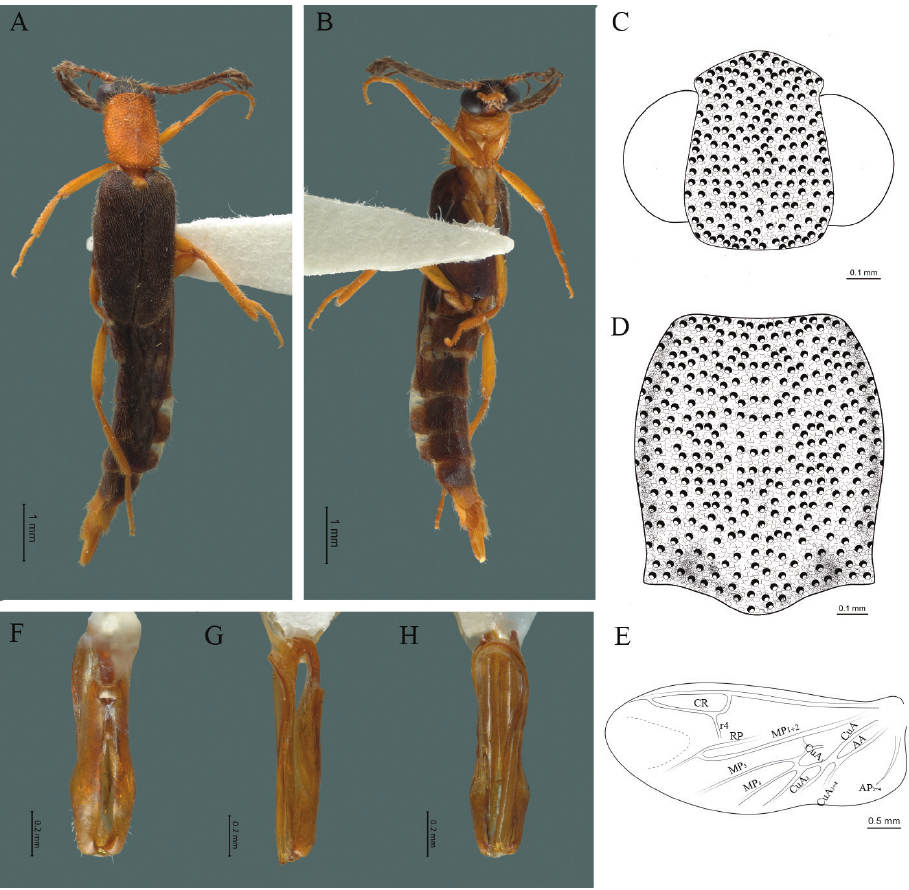
Figure 14. Cenophengus longicollis Wittmer, 1976, male. Habitus: A dorsal B ventral C head dorsal D pronotum dorsal E hind wing. Wing venation: CR = Radial Cell; r4 = radial 4 vein; RP = Posterior Radial vein; MP1+2 = Posterior Median vein; CuA = Cubital vein; AA and AP = Anterior and Posterior Anal veins. Aedeagus: F dorsal view G lateral view H ventral